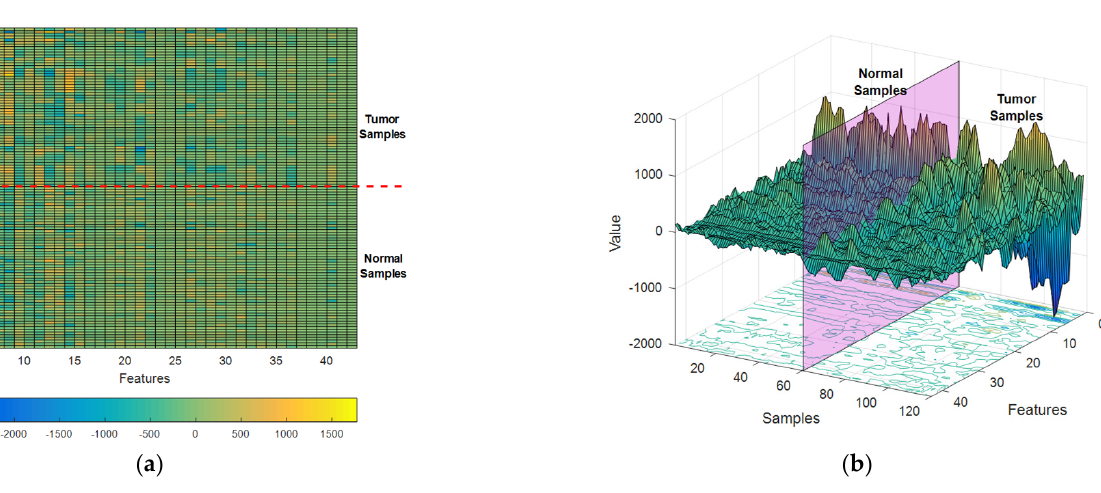
Figure 5. ( a ) The colormap, and ( b ) the surface plot of the features extracted through SVD algorithm.